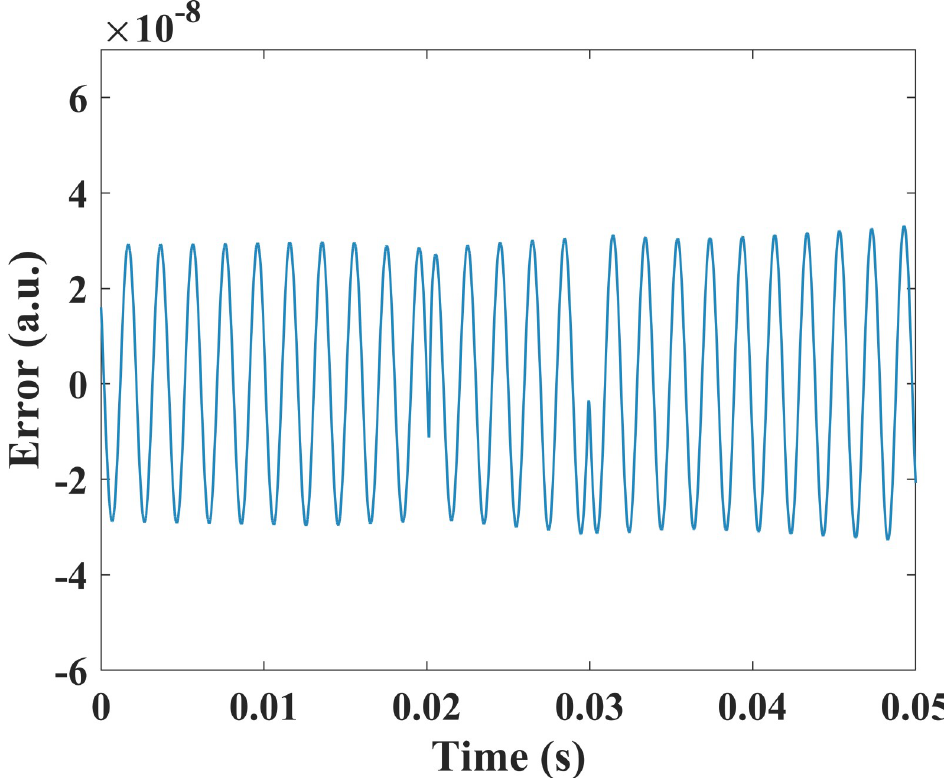
Fig 5. The error between the second harmonic demodulated by the two